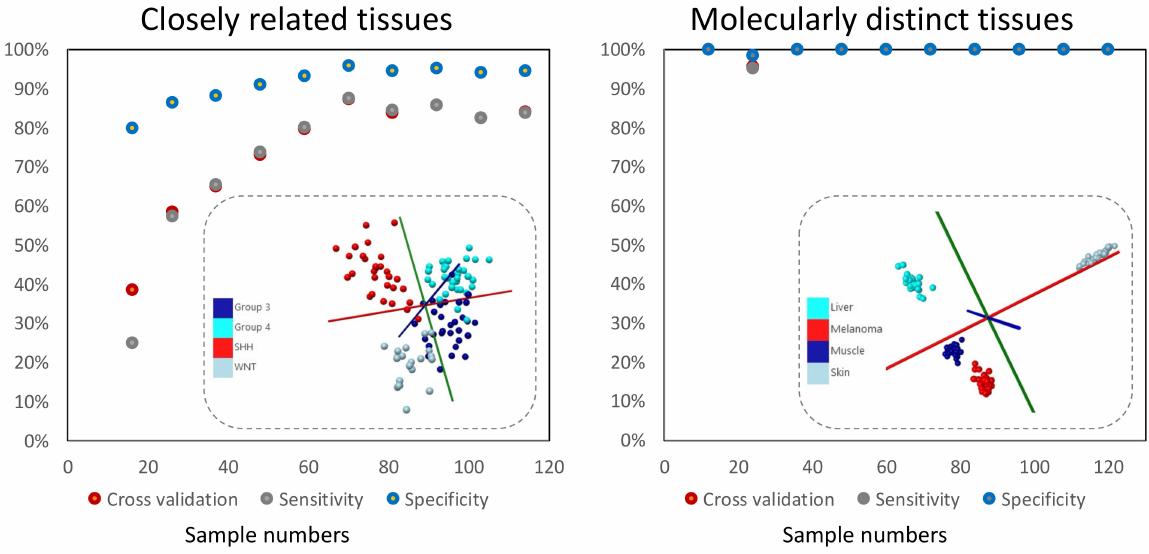
Figure 3. The influence of sample size on the predictive power of ambient MS methods. In this figure we re-analyzed previously published [9] and newly acquired picosecond infrared laser mass spectrometry (PIRL-MS) data from two cases of 4 closely related tissues (subgroups of human pediatric brain cancer medulloblastoma) and 4 distinct tissue types (murine melanoma and additional liver, muscle and skin tissues). Each dataset is comprised of a 10-s ambient PIRL-MS sampling ( m / z range 100–1000 Da) subjected to principal component analysis and linear discriminant analysis (PCA-LDA), as described previously [9]. Cross validation was performed on AMX [144] using a 20% leave out [9], and was used to calculate the specificity and sensitivity. For each specimen, one 10-s PIRL-MS spectrum has been included. However, in keeping with the recommendations of Nyangoma et al. [135] (see above), multiple sampling of each specimen towards developing the extent of intrasample variation has been reported in our original publication [9]. As can be seen here, where there is significant intrasample variability (large spread of data points for each class in the PCA-LDA scores plot) and where classes are more molecularly alike, larger sample numbers are required to reach prediction power plateau compared with cases where less variant, molecularly distinct classes are compared. In this comparison, each class contained ~30 specimens (and one PIRL-MS spectrum per